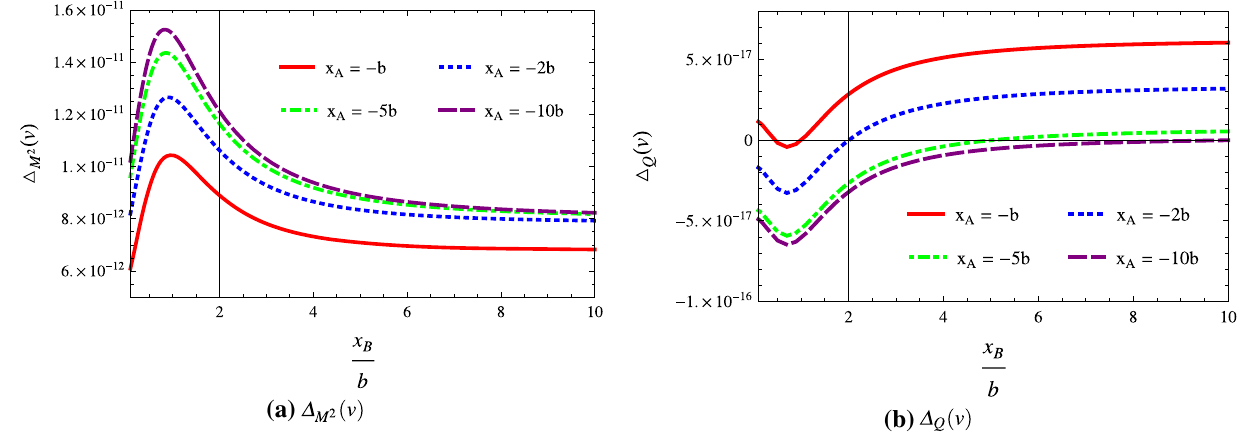
Fig. 4 Δ M 2 (v) and Δ Q (v) plotted as the functions of x B for various x A , respectively. As an example, b = 1 . 0 × 10 4 M , Q = 0 . 01 M , and v = 1 . 0 × 10 − 4 are